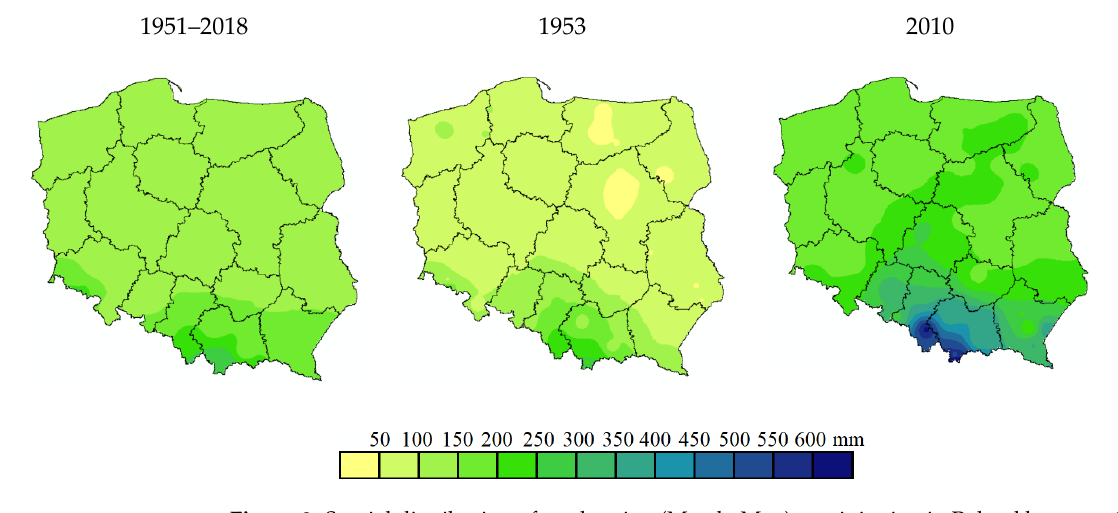
Figure 3. Spatial distribution of total spring (March–May) precipitation in Poland between 1951–2018 (multi-year period), 1953 (the lowest in the multi-year period) and 2010 (the highest in the multi-year period).